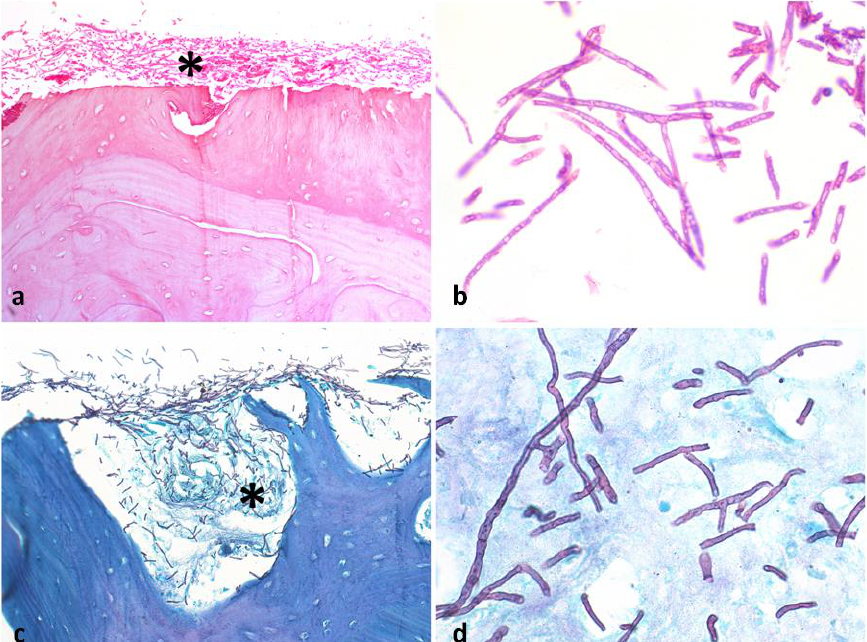
Figure 2. Histopathological features of mandibular Aspergillus osteomyelitis. ( a ) Necrotic bone fragment showing large number of fungal hyphae at the periphery (HE, orig. mag. 20×). ( b ) High-power photomicrograph shows septate hyphae with dichotomous 45 ◦ branching, characteristic of Aspergillus species (HE, orig. mag. 100 × ). ( c , d ) Grocott–Gomori methenamine silver stain highlighting As- pergillus hyphae colonizing the necrotic bone (orig. mag. 20 × ( c ) and 100 × ( d )). Asterisks indicate septate Aspergillus hyphae.